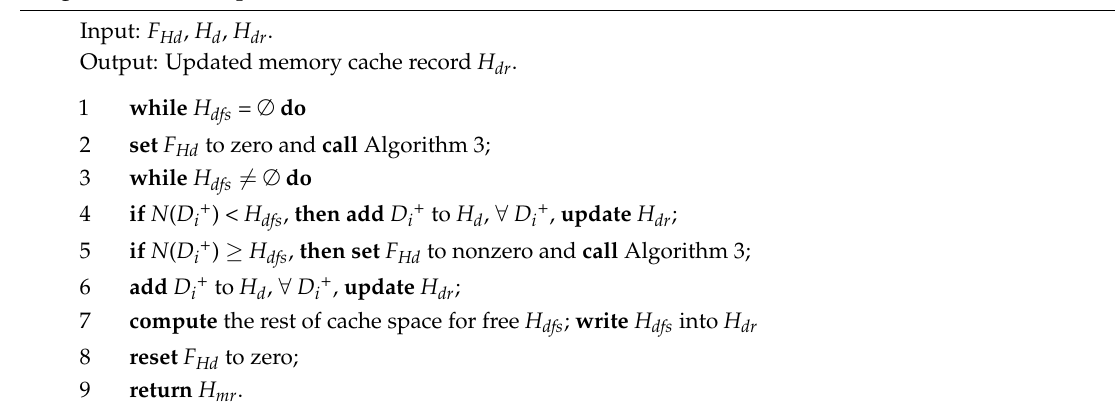
Algorithm 5. Add up-to-date data to the disk cache